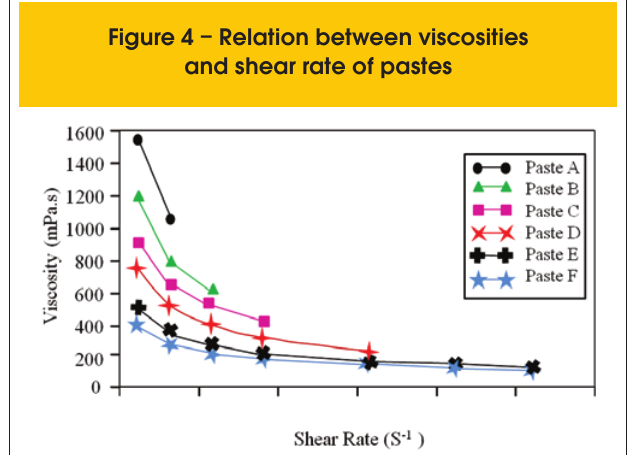
Figure 4 – Relation between viscosities and shear rate of